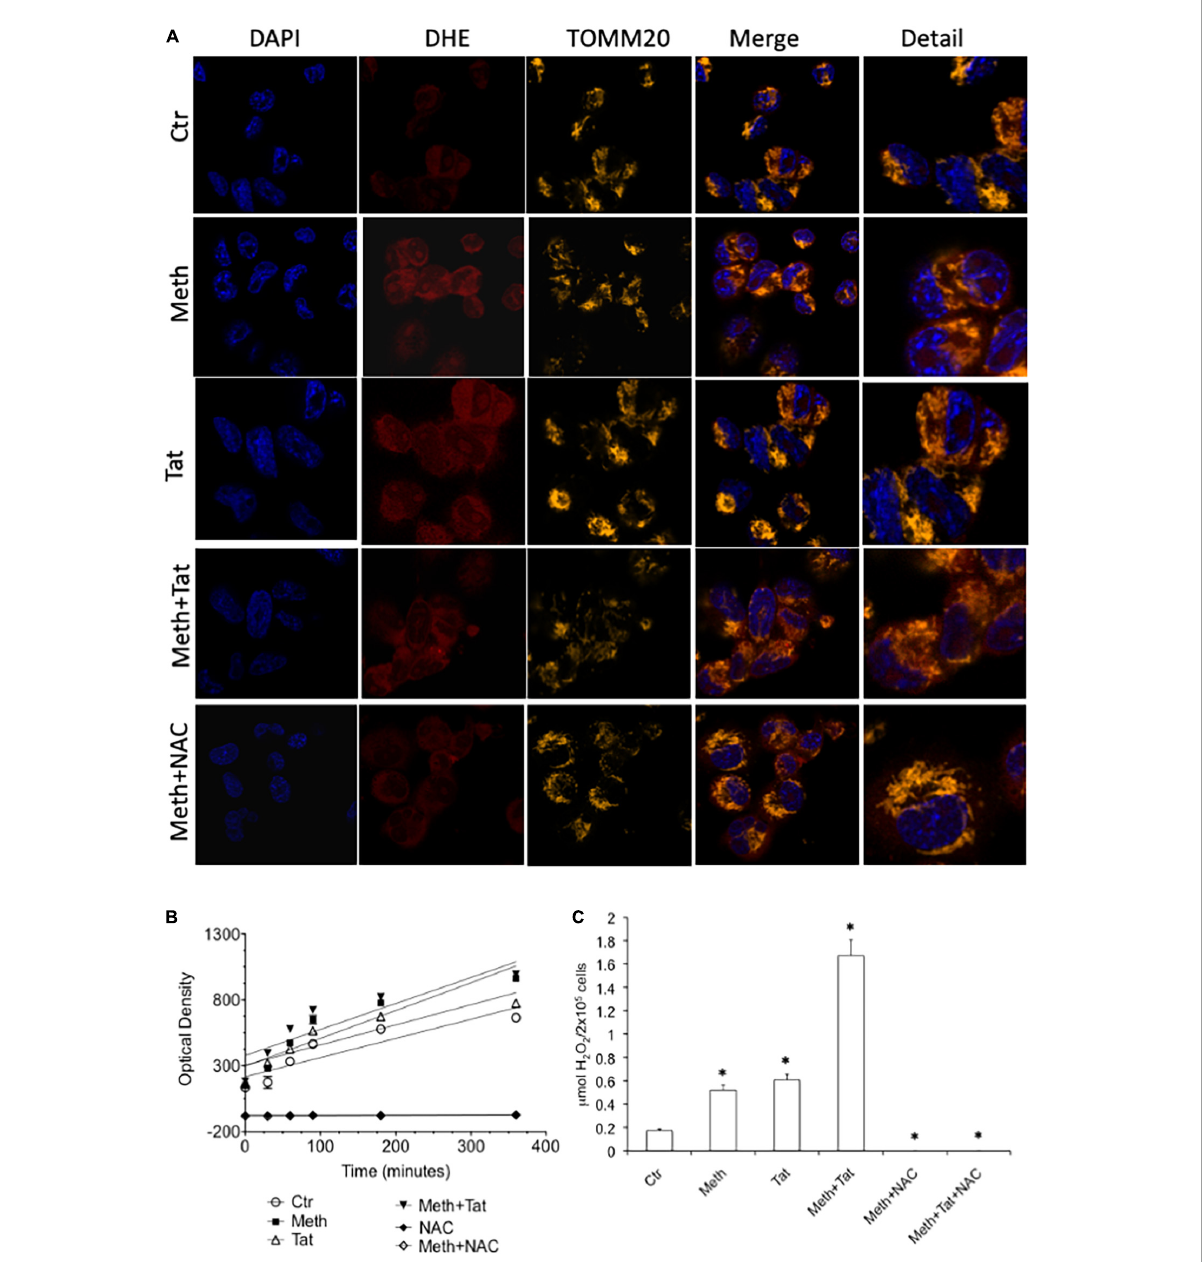
FIGURE1 Meth induces ROS acutely in innate immune cells. The increase of ROS was examined in real time THP1 macrophages following the treatment with 60uM Meth, 10 ng/ml HIV Tat, or both together. The ROS scavenger NAC (1 uM) was added to cultures at time of stimulation. (A) Superoxide detection by DHE staining. DAPI was used for identifying the cell nucleus, and TOMM20 was used to identify mitochondria. Merging demonstrates that DHE is not solely associated to TOMM20 + mitochondria in macrophages, but it is also in the cell cytoplasm. (B) Amplex Red luminescence was used to detect H 2 O 2 in real time for 360 minutes following stimulation. The graph shows the average of a triplicate, in one representative experiment, out of 5 performed. (C) The molarity of released H 2 O 2 was calculated at 60 min, for all the conditions analyzed, n = 5 triplicates. * p < 0.05 compared to vehicle treated controls